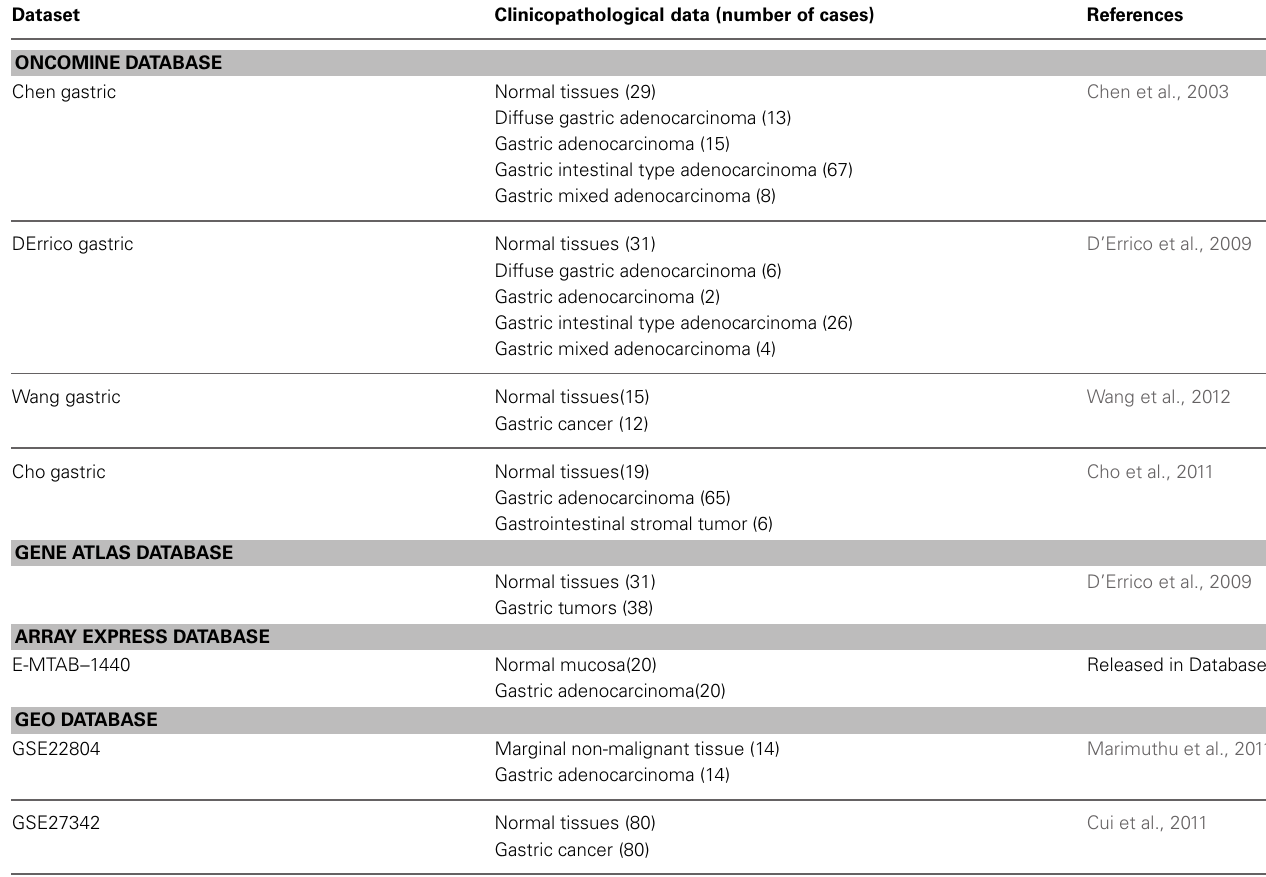
Table 1 | Different datasets and their clinicopathological data used in the current study. Dataset